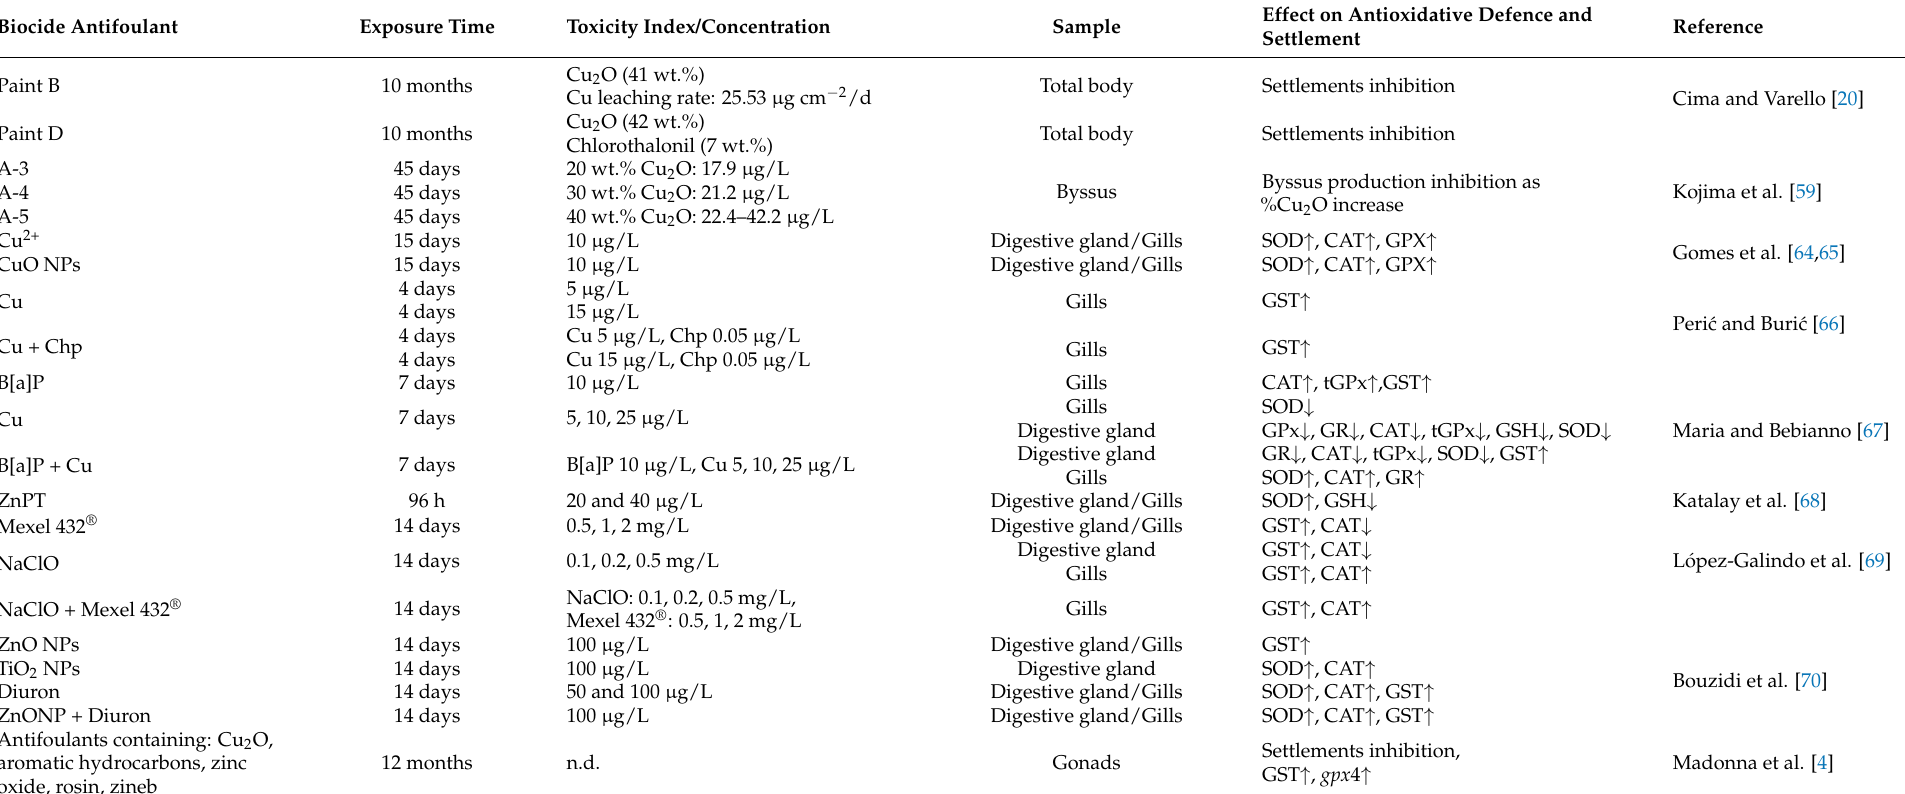
Table 1. Summarized results and data references for biocide antifoulants occurring in Mytilus galloprovincialis